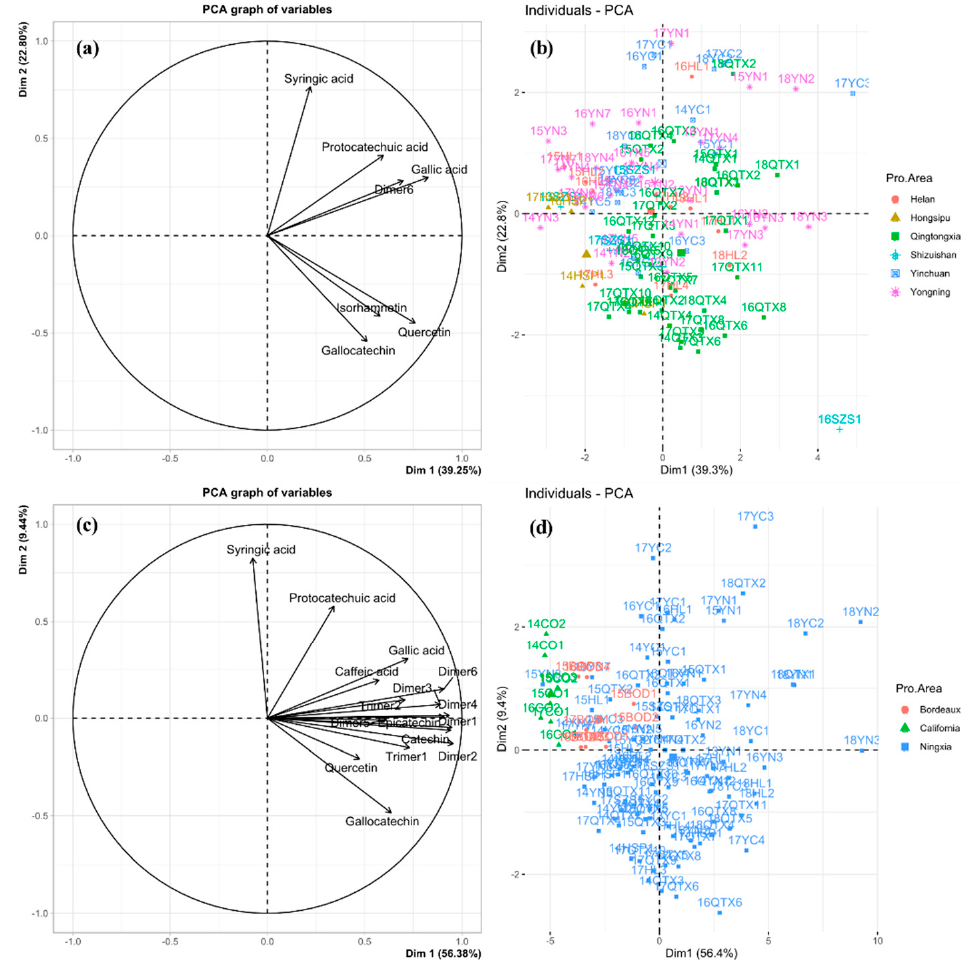
Figure 5. PCA (principal components analysis) scores plot for wines based on phenolic compounds of six sub-regions of Ningxia ( a ) and three wine-producing regions ( c ). PCA loadings plot of volatile compounds of six sub-regions of Ningxia ( b ) and three wine-producing regions ( d ).